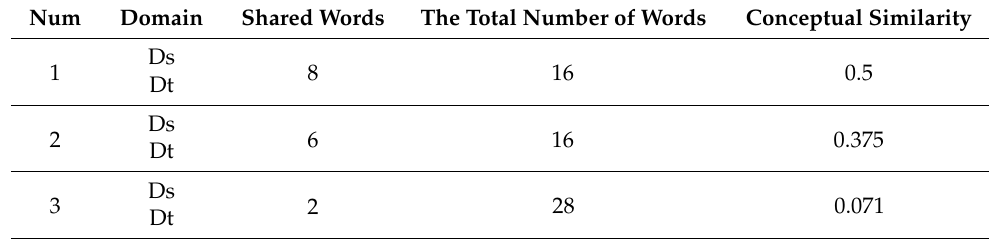
Table 3. Conceptual similarity of T1 time slice data in the D s and D t .